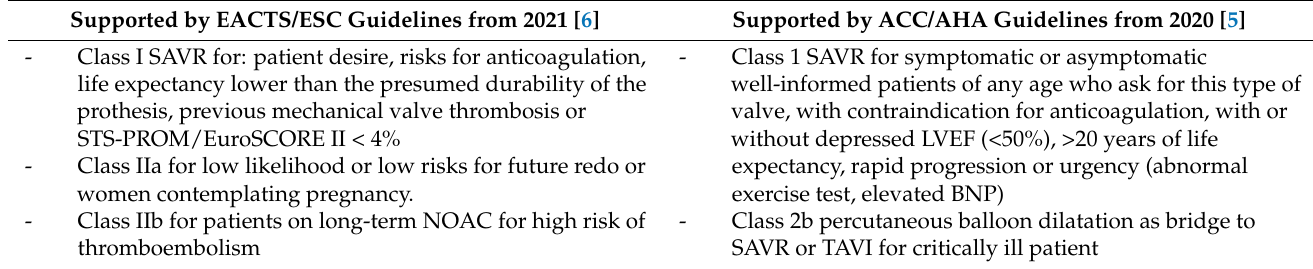
Table 3. Decision Making Algorithm. Bio-SAVR for young